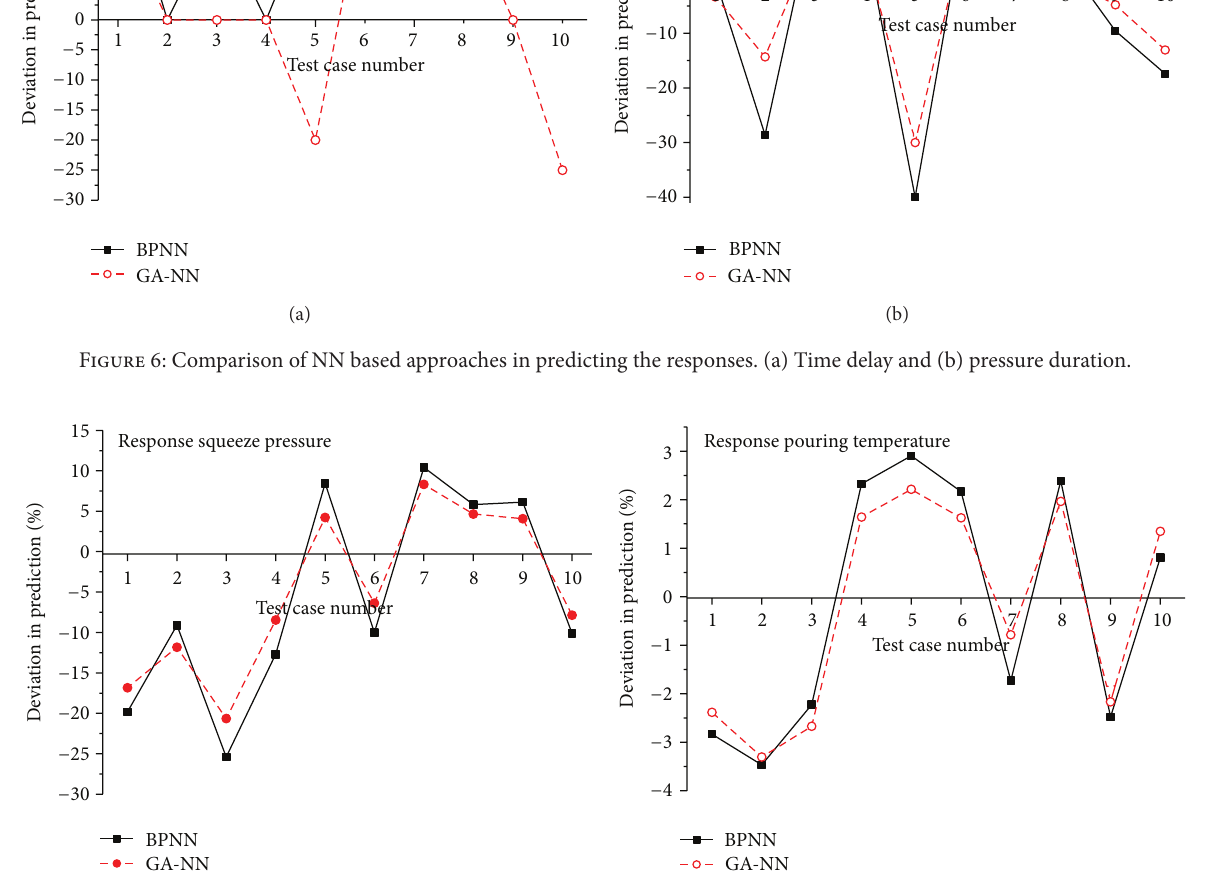
GA-NN. The GA-NN model performs better as compared to BPNN and it is better explained with respect to the average absolute percent deviation in prediction. The average absolute percent deviation in prediction of the response die temperature is found to be equal to 7.51% for BPNN and 4.63% under GA-NN model,